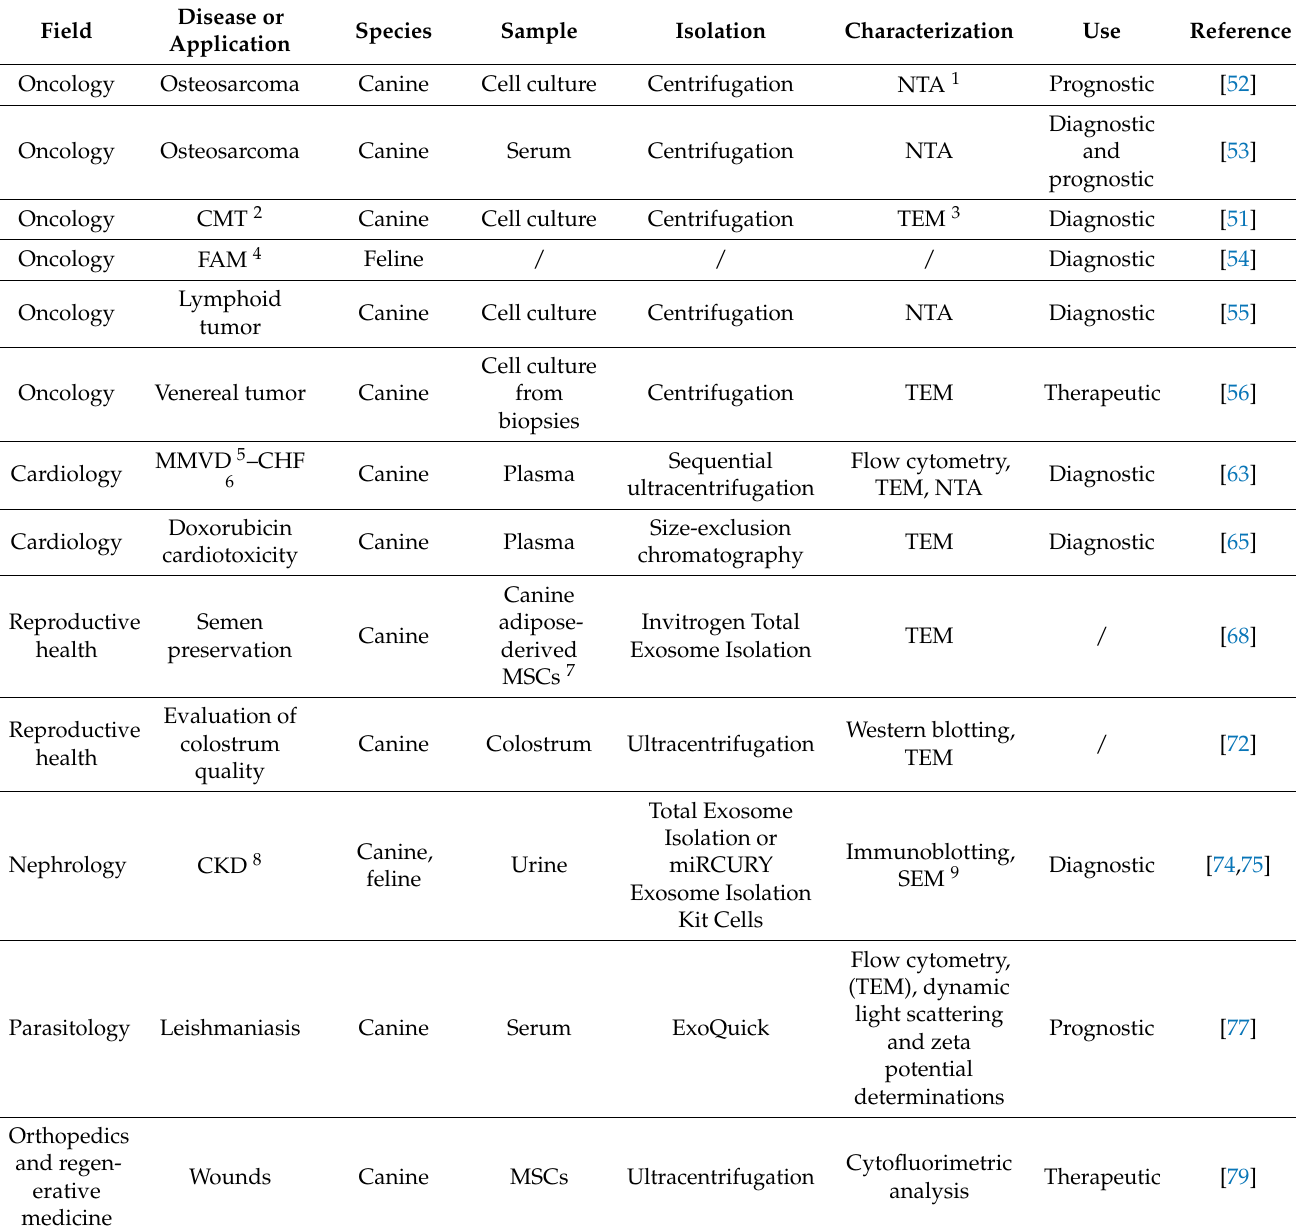
Table 1. Overview of the current applications of exosomes in veterinary